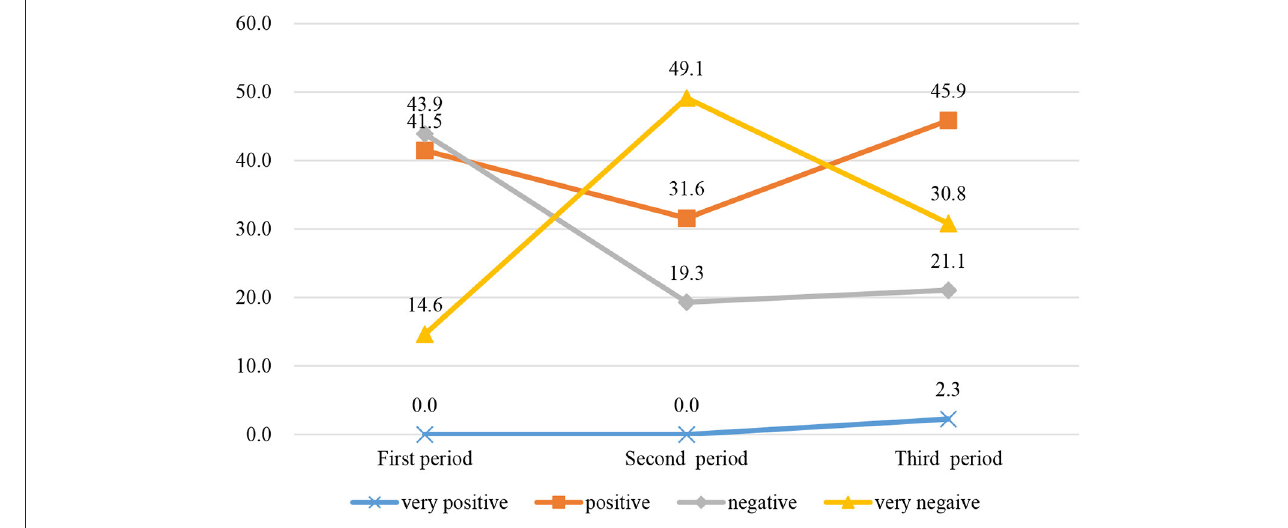
FIGURE 3 | The evolution of group members’ emotions in three periods.